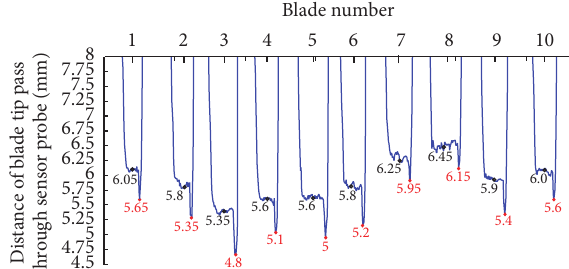
Receiving power of RFa/receiving power of RFb